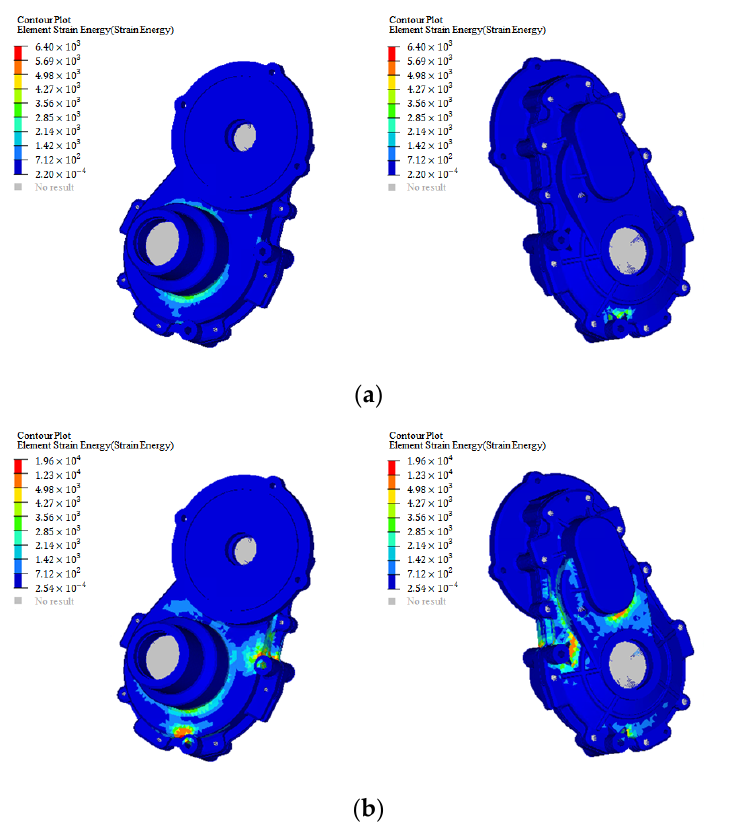
Figure 13. Elastic strain energy (ESE) for clockwise drive. ( a ): ESE of mode shape at 813 Hz; ( b ): ESE of mode shape at 1237 Hz.